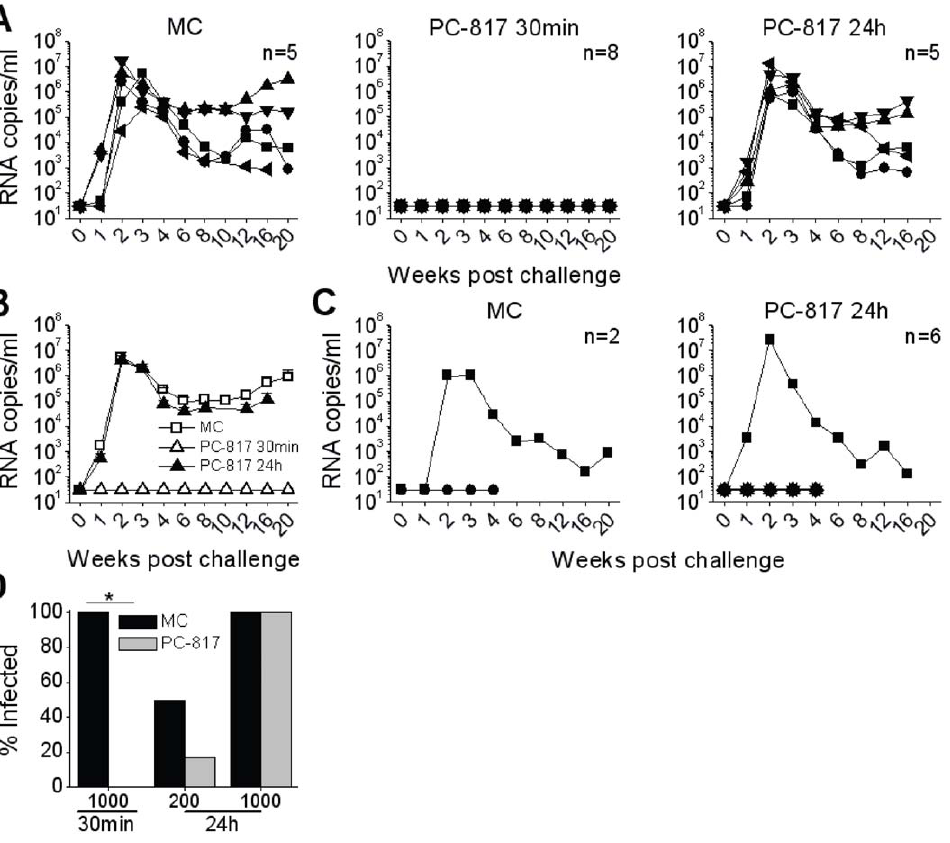
Figure 6. PC-817 protects against vaginal SHIV-RT infection when given just prior to HSV-2/SHIV-RT co-challenge. (A) PC-817 or MC was applied 30 minutes (30 min) and 24 hours (24 h) prior to challenge of HSV-2-exposed animals with 10 3 TCID 50 SHIV-RT and 2 6 10 8 pfu HSV-2. Plasma viral loads are shown for control animals (MC) (n=5) in the left panel, for animals that received PC-817 30 min before the challenge (n=8) in the middle panel, and for animals that received PC-817 24 h prior to challenge (n=5) in the right panel. (B) Mean ( 6 SEM) plasma viremia of the 3 treatment groups from (A) are shown. (C) PC-817 or MC was applied 24 h prior to challenge with 200 TCID 50 of SHIV-RT and 2 6 10 8 pfu HSV-2. The plasma viral loads are provided for the MC control animals (n=2) in the left panel and the PC-817-treated animals (n=6) in the right panel. (D) Data from panels (A) and (C) are summarized to show the frequency of infection for the differently treated groups. The asterisk highlights the statistically significant (P , 0.001) difference in the numbers of infected animals receiving PC-817 (vs MC) 30 min prior to challenge with 10 3 TCID 50 of SHIV-RT and HSV-2.